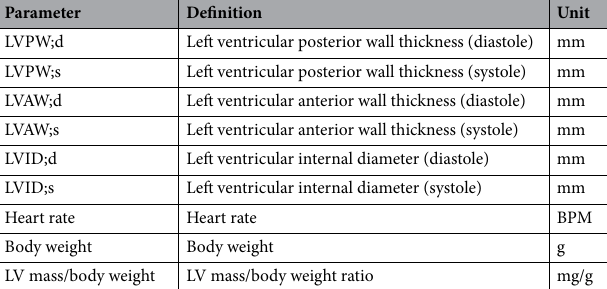
Table 2. Measurement definitions short axis